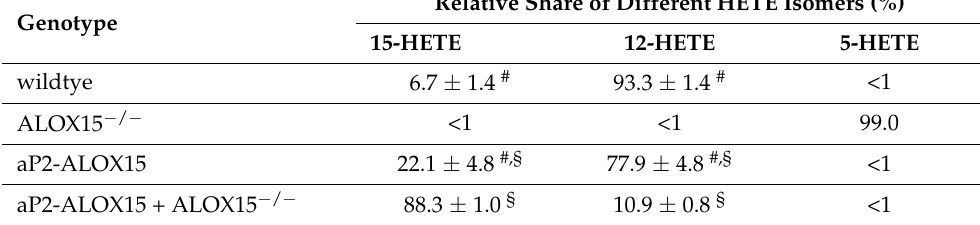
Table 1. Ex vivo activity assays of peritoneal lavage cells prepared from mice of different genotype. 10 7 peritoneal lavage cells prepared from mice of different genotypes (n = 3 of each genotype) were incubated with exogenously added arachidonic acid as described in Section 4. The arachidonic- acid-derived oxygenation products were prepared and further analyzed by RP-HPLC. The statistical evaluation of the experimental raw data was performed using the Student’s t-test function of the Microsoft Excel software package. # wildtype mice vs. aP2-ALOX15 animals, p < 0.01, § aP2-ALOX15 mice vs. aP2-ALOX15 + ALOX15 − / − animals p < 0.01. Relative Share of Different HETE Isomers (%) Genotype 15-HETE 12-HETE 5-HETE wildtye 6.7 ± 1.4 # 93.3 ± 1.4 # <1 ALOX15 − / − <1 <1 99.0